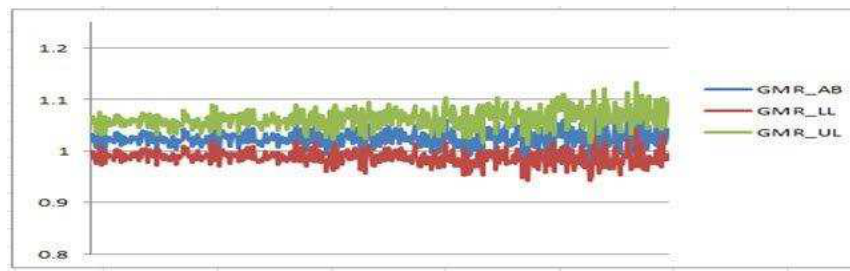
Figure 1 – Graphical represenation of GMR, LL and UL